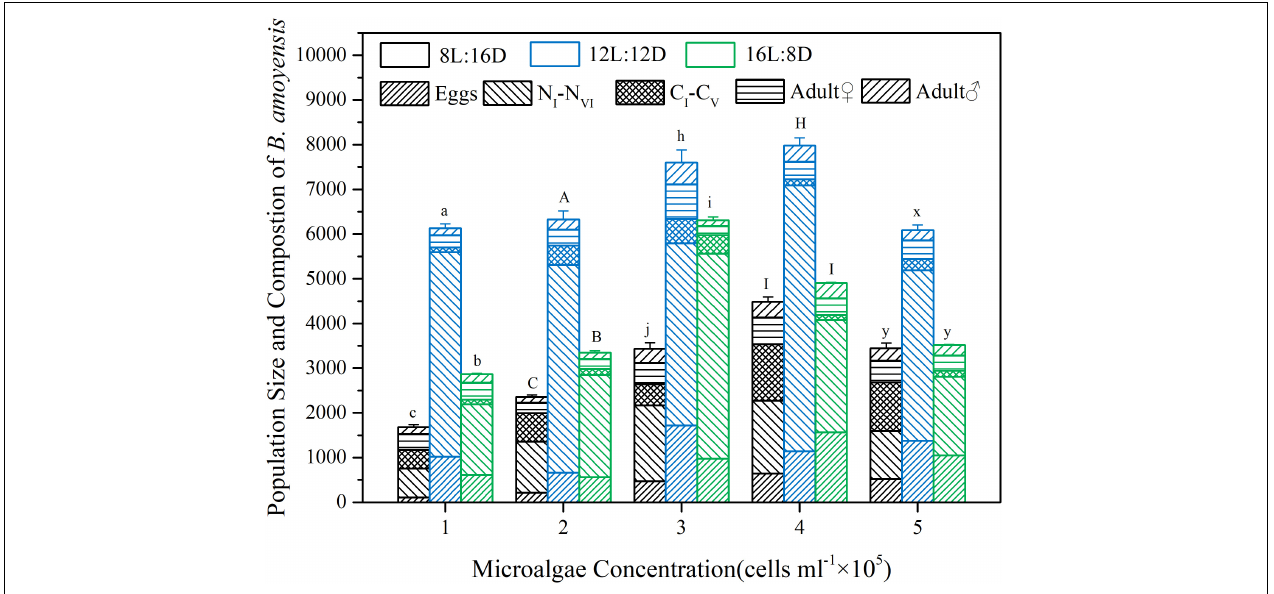
FIGURE 4 | Effects of different concentrations of the microalgal diet and photoperiod regimes on population size and population structure of B. amoyensis over 12 days of cultivation ( N = 3). Data is presented as mean ± SE. Different letters on the top of bars indicate significant differences of different photoperiod treatments at the same microalgae feeding concentration ( p <